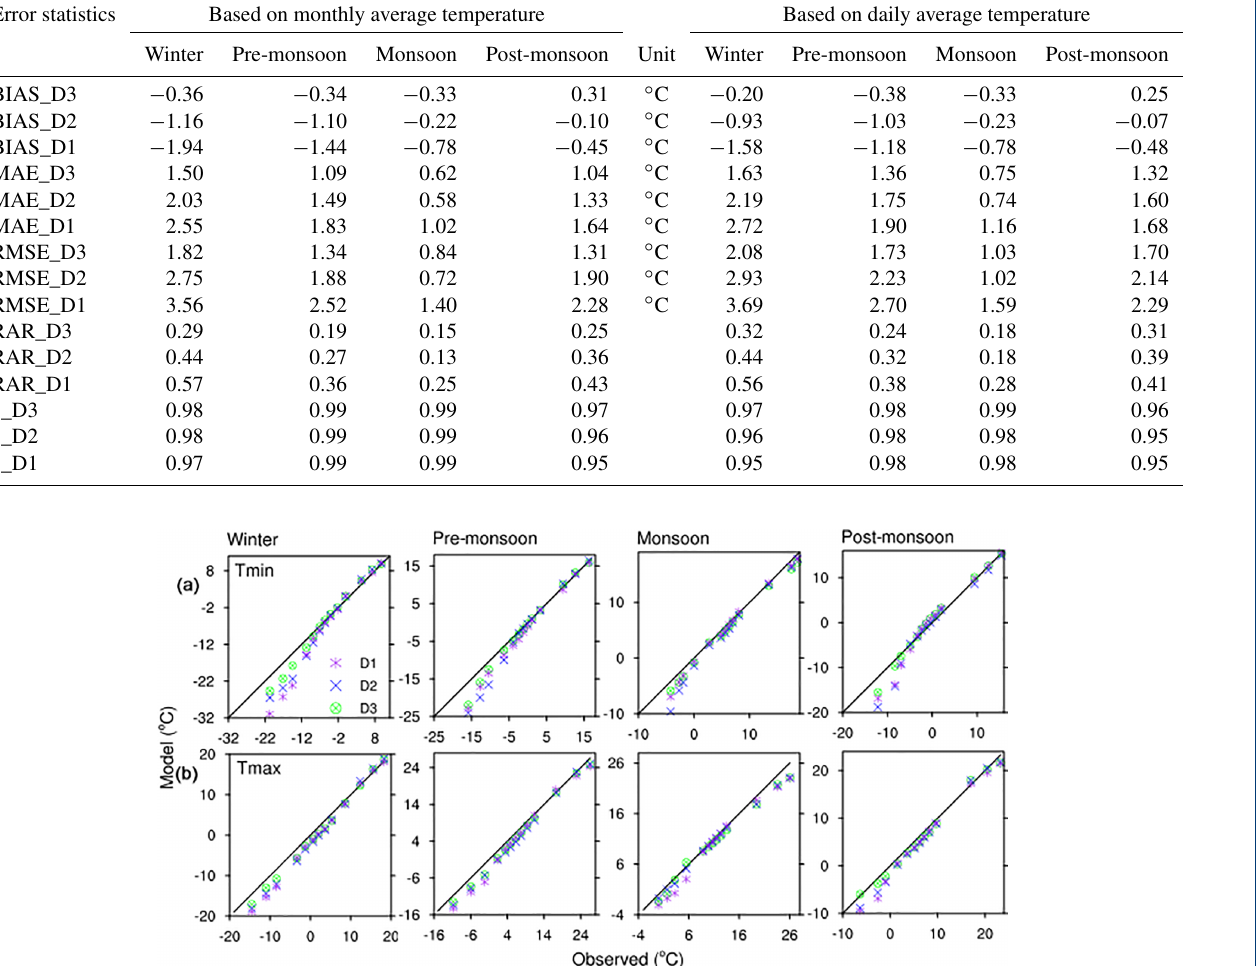
Table 4. Seasonal error statistics (pooled data) based on monthly and daily average temperature. (Abbreviations are the same as in Table 3 for statistics that appear in both tables. Additional abbreviations are as follows: BIAS – WRF – Obs; MAE – mean absolute error).